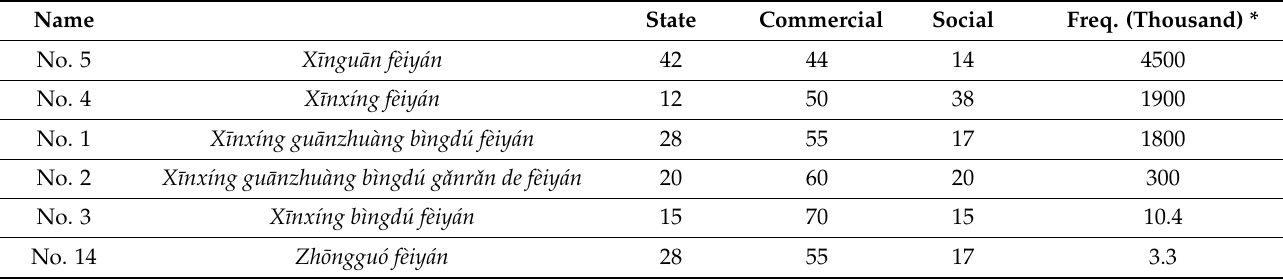
Table 3. Frequency and percentage distribution of six terms shared across channels; coronavirus disease name survey